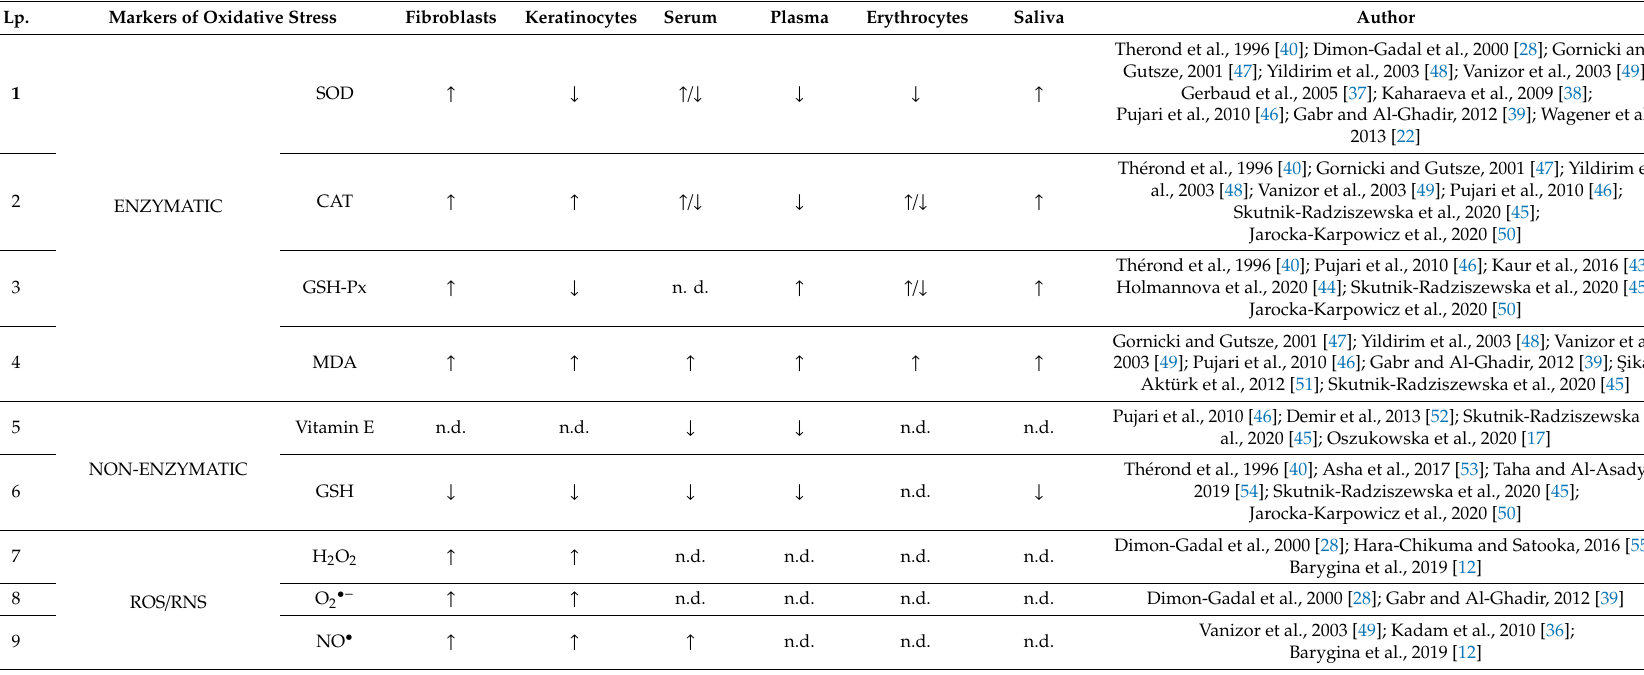
Table 1. The level of the main markers of oxidative stress in relation to the place of sample